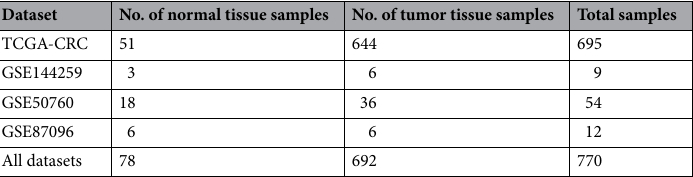
Table 1. Sample distribution of TCGA-CRC and GEO datasets for normal tissue and tumor tissue samples.